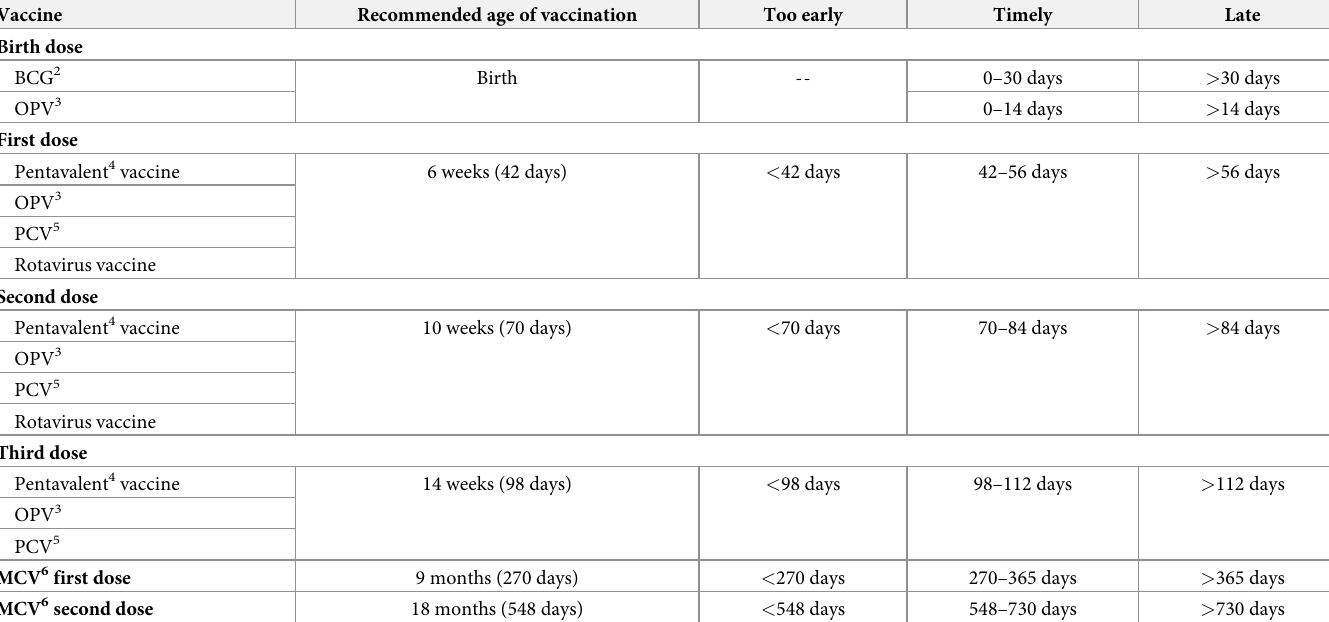
Table 1. Time intervals used for classifying timeliness of vaccination doses received by surveyed children ( < 24 months), using the nationally recommended ages for vaccination, missed opportunities for vaccination (MOV) assessment, Kenya, 2016 1 . Vaccine Recommended age of vaccination Too early Timely